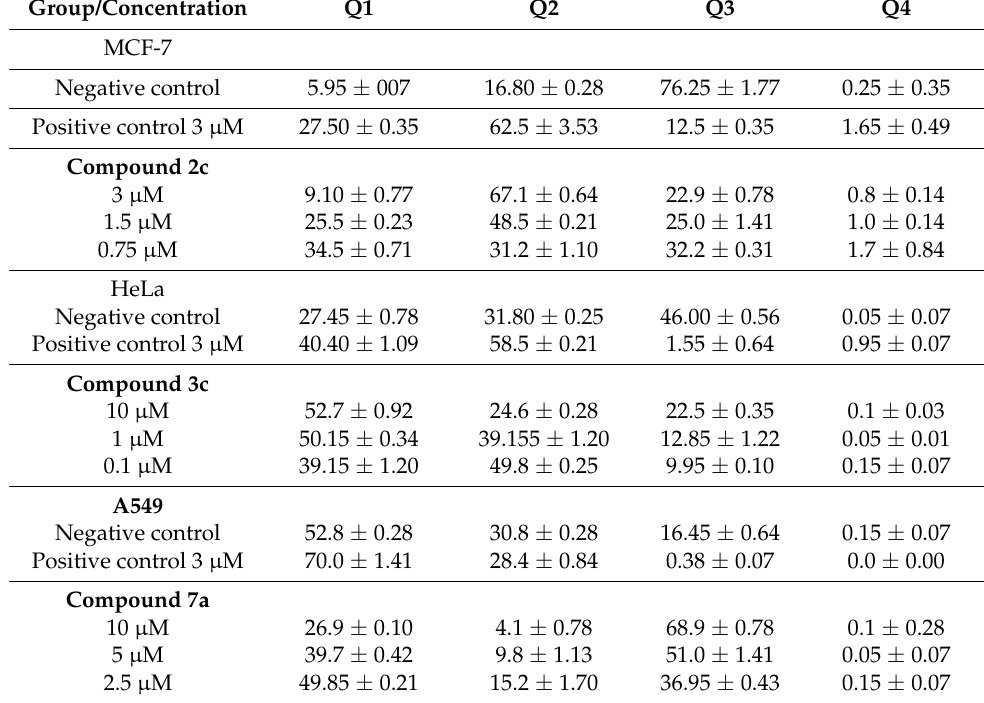
Quantitative apoptosis assay of A549 using Annexin-V/PI dual staining method. The percentage of viable cells, early apoptotic cells, late apoptotic cells, and necrotic cells are presented as mean ±